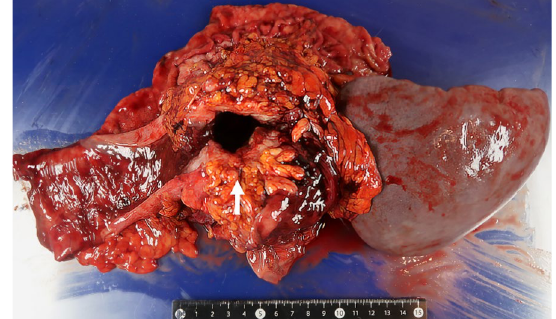
Fig. 4 A radical en bloc resection involving a left hemicolectomy, distal gastrectomy, distal pancreatectomy, and splenectomy was conducted. The white arrow indicates the gastrocolic fistula that was created by the transverse colon